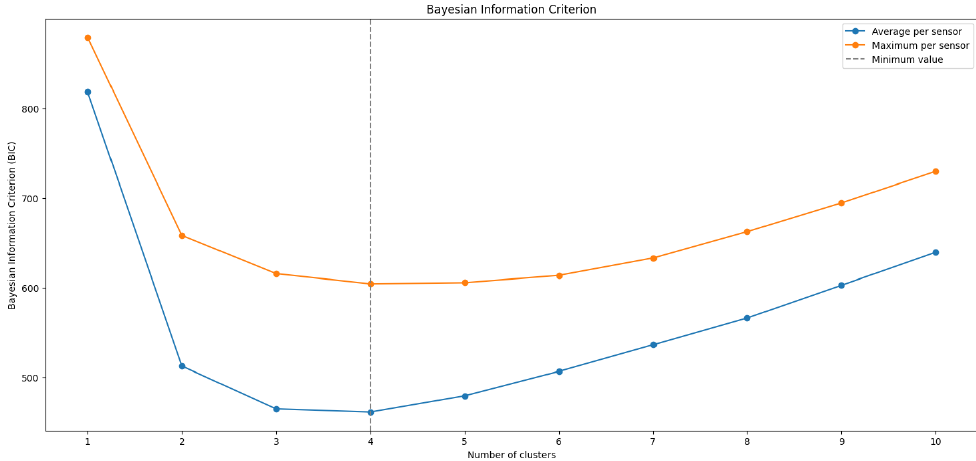
Figure 7. Bayesian Information Criterion for maximum and average values per